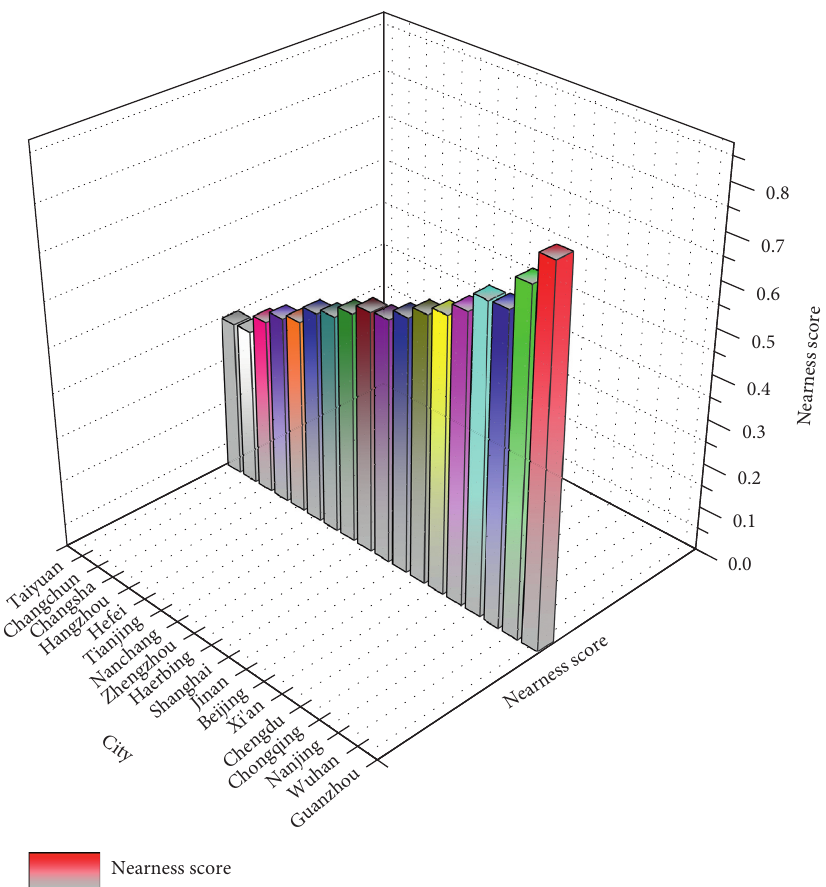
Figure 6: Statistical chart of closeness degree of higher education resource carrying